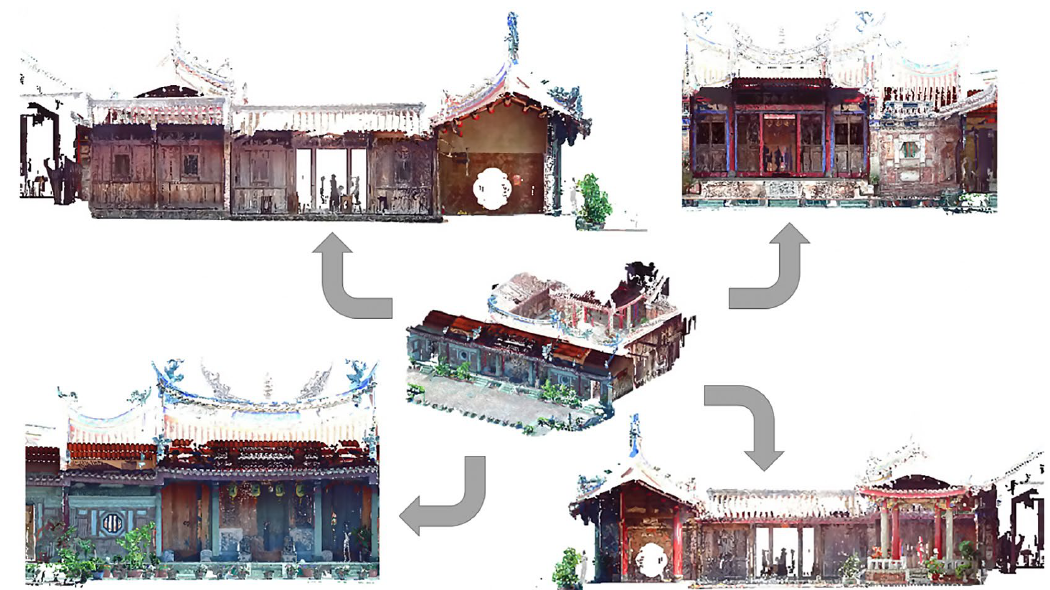
Figure 6. Point cloud of Huangxi Academy